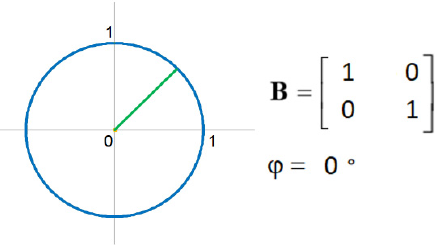
Figure 11. General tensor for rotational matrix with angle ϕ = 0 ◦ .